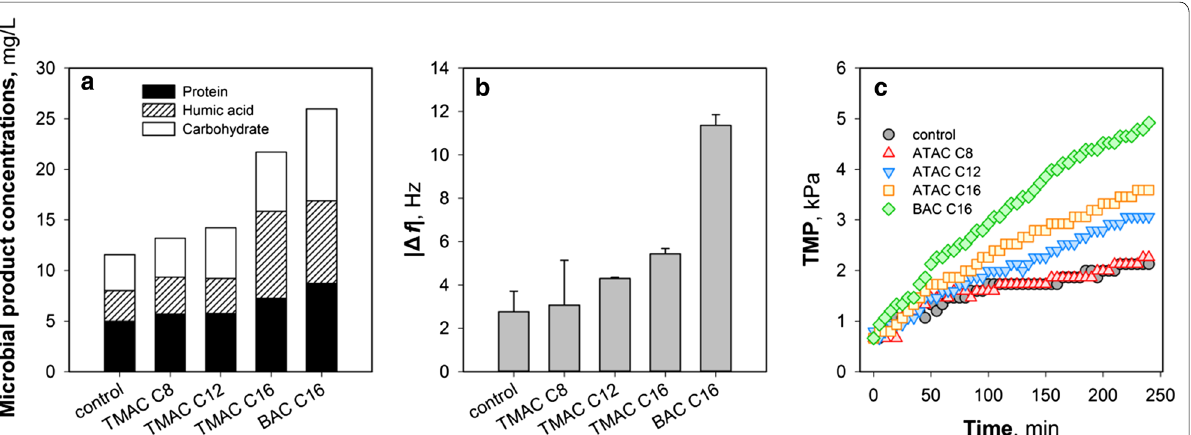
Fig. 4 Variations of a microbial products and b adhesion and fluidity properties of the microbial products following exposure of the samples to different kinds of QACs for 2 h. The adhesion and fluidity properties are evaluated by the frequency shifts (∆ f ) at the third overtone after the adsorption of microbial products on QCM-D sensors. c Time-course results of the transmembrane pressure (TMP) in an MBR under the shock loads of different kinds of